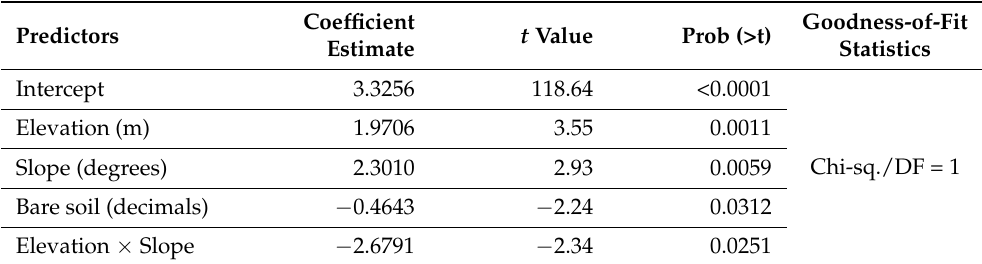
Table 8. Standardised coefficient estimates of the fixed effects involved in the GLMM fitting the log (species richness) against site variables in all Artemisia alba -(co)dominated communities ( n = 43) from the Carpathian and Pontic regions (Romania). Elevation and slope were square-root transformed prior to